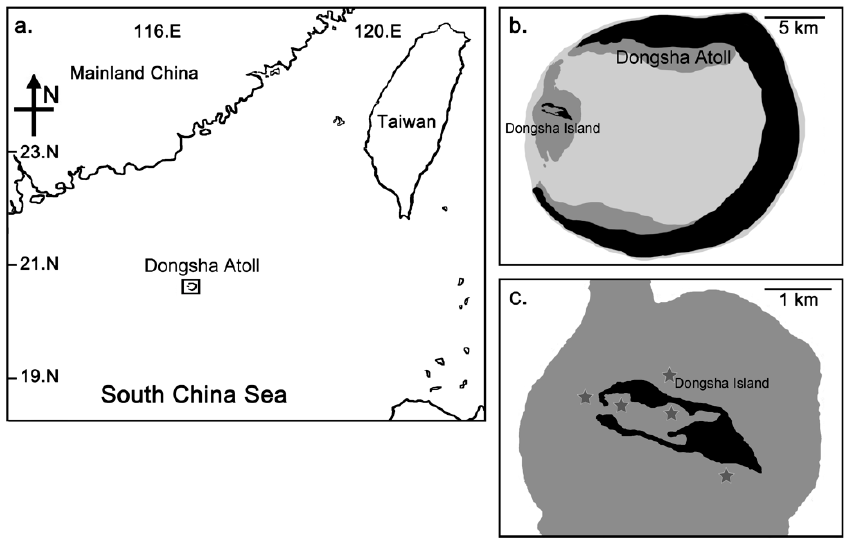
Figure 1. Maps showing ( a ) the location of Dongsha Atoll in the South China Sea; ( b ) the position of Dongsha Island in the Atoll; the dark gray area indicates the distribution of seagrass beds around Dongsha Island; and ( c ) the modeling area of seagrass beds around Dongsha Island. The locations of five study sites are shown by stars.